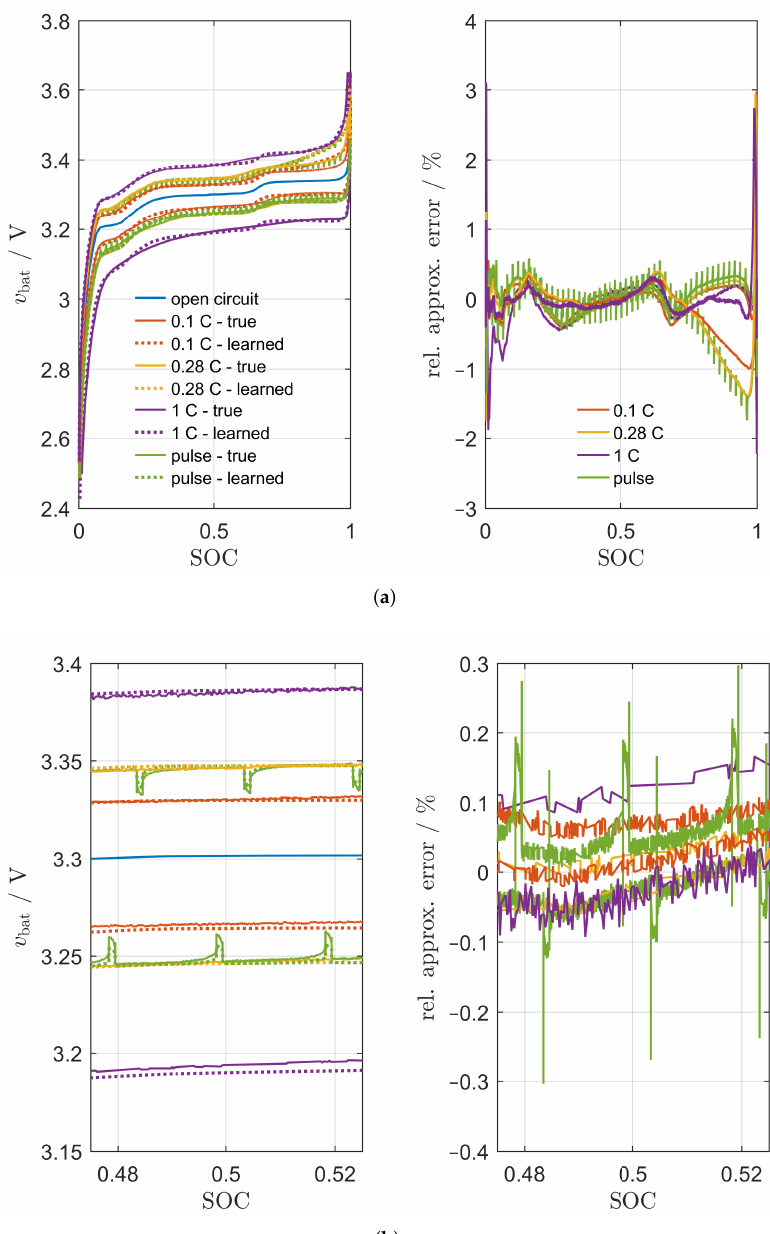
Figure 7. Simulation results using NODEs for grey-box modelling of a lithium-ion battery in compar- ison to experimental data; left: charge and discharge curves for different C-rates at T = 25°C. The lower branches represent discharge (time progresses from right to left), while the upper branches represent charge (time progresses from left to right); right: relative approximation error; ( a ) the whole SOC range ( b ) focus on medium